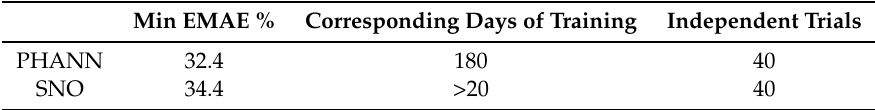
Table 3. Results of Case (A).